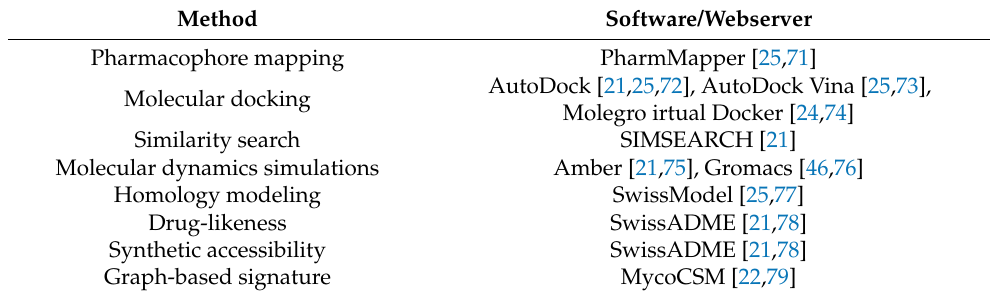
Table 4. Some in silico tools and webservers employed for multitasking